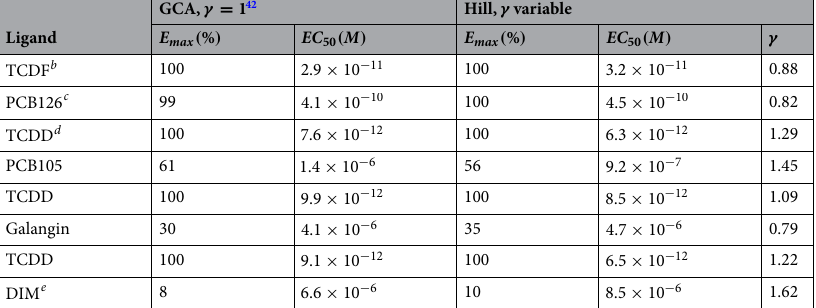
Table 3. AhR agonist parameters from GCA- and Hill-models. Parameters are slopes γ , maximum effects E max and EC 50 values of the agents. b 2,3,7,8-tetrachlorodibenzofuran; c 2,3,3’,4,4’-petachlorobiphenyl; d